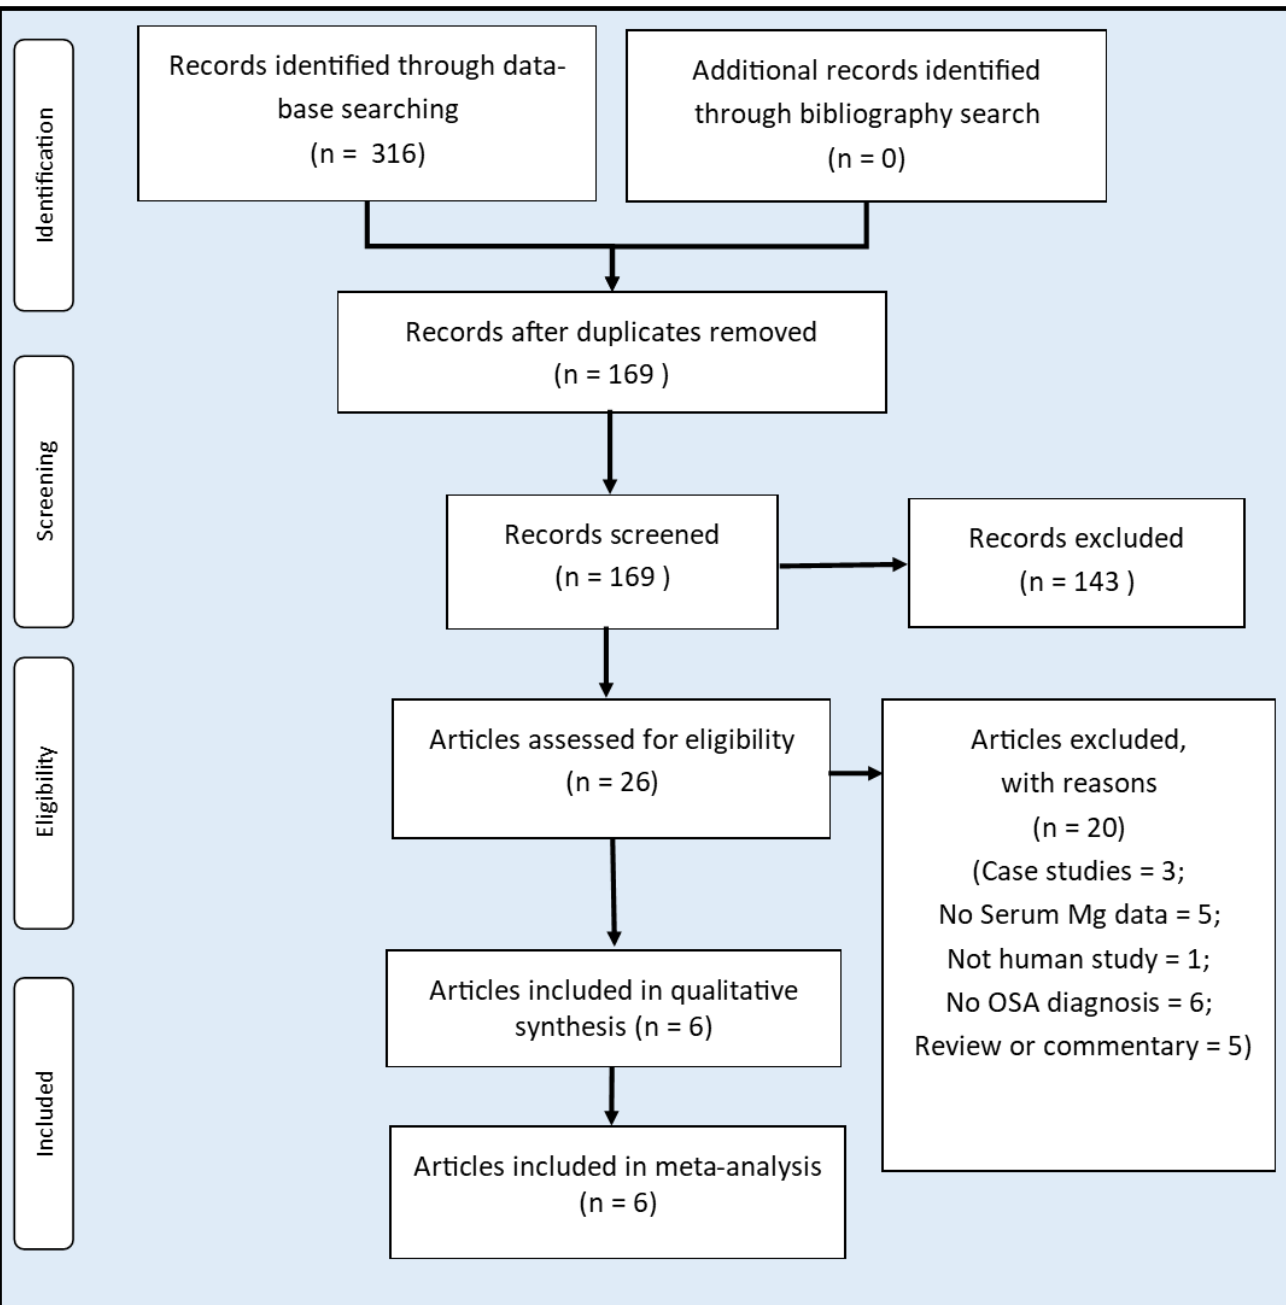
Figure 1. Flow diagram of study